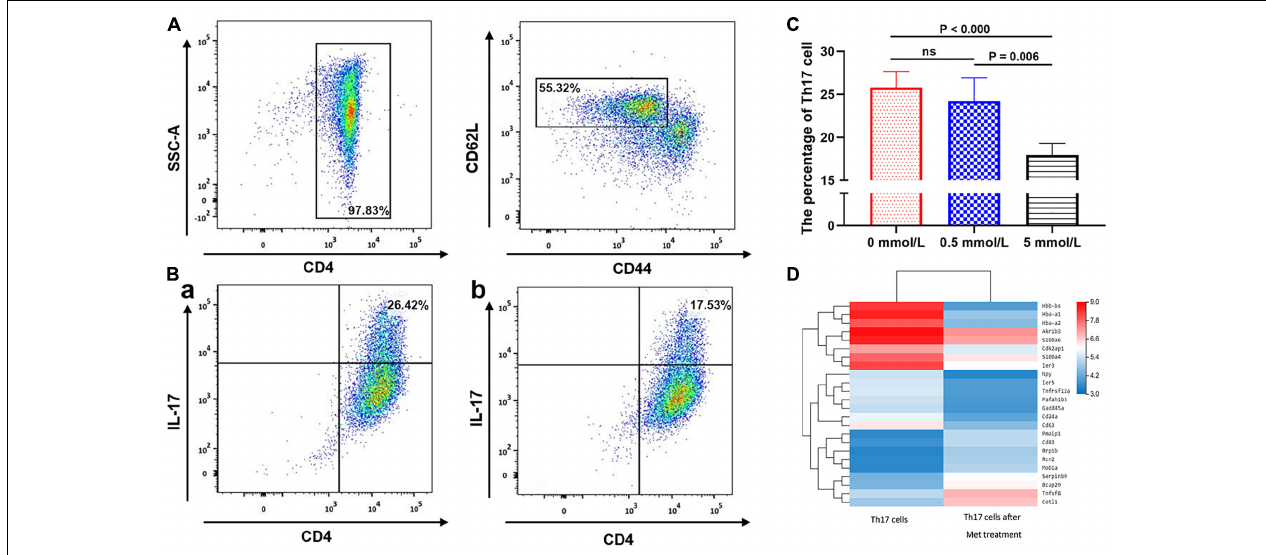
FIGURE 4 | The effect of metformin on the differentiation of Naive T cells into Th17 cells. (A) Flow cytometry diagram of Naïve T cells. (B) Flow cytometry diagram of Th17 cells, (a) 0 mmol/L metformin, (b) 5 mmol/L metformin. (C) Proportion of Th17 cell differentiation under different metformin concentrations. (D) Differences in the mRNA transcriptome of Th17 cells before and after metformin treatment. The percentages shown in (A,B) were the mean value of the corresponding groups.